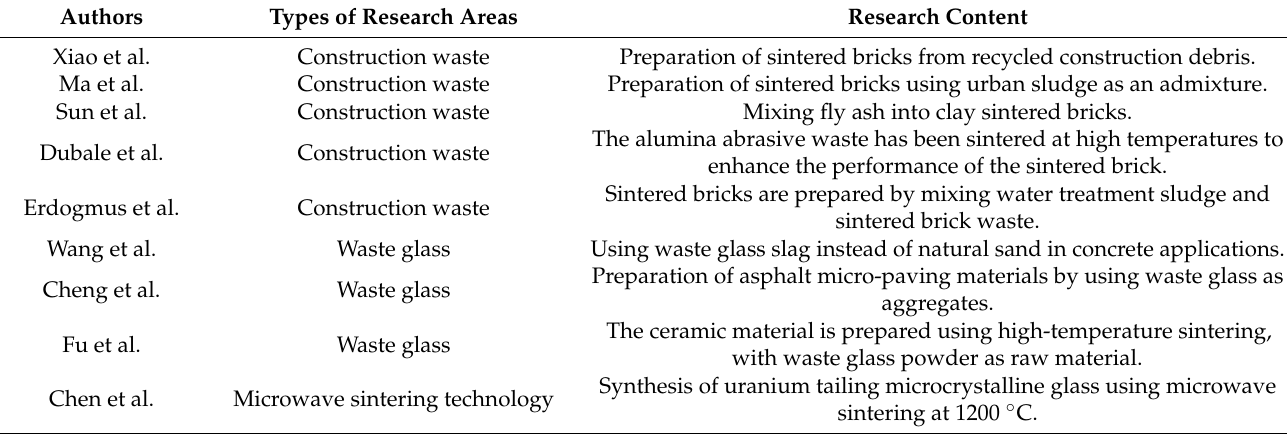
Table 1. Summary of previous studies.